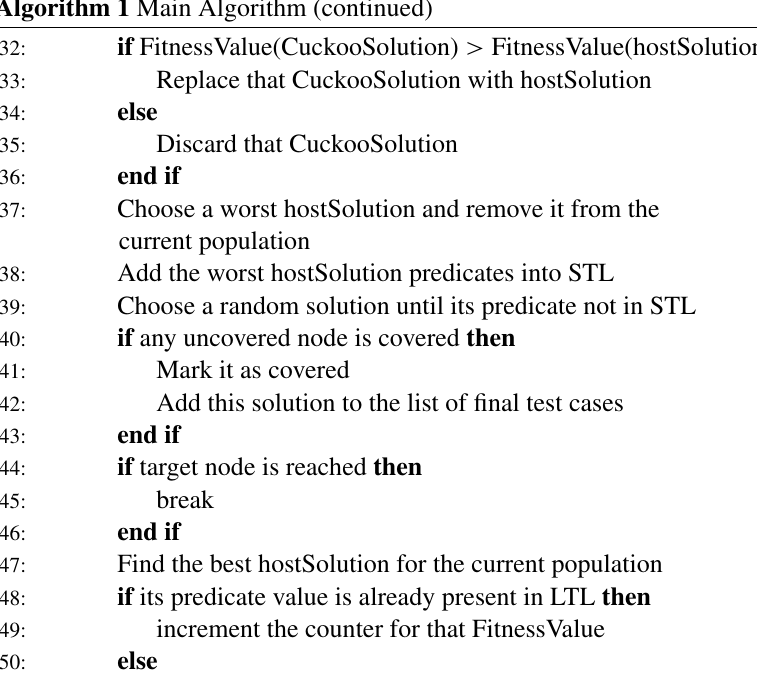
Algorithm 1 Main Algorithm